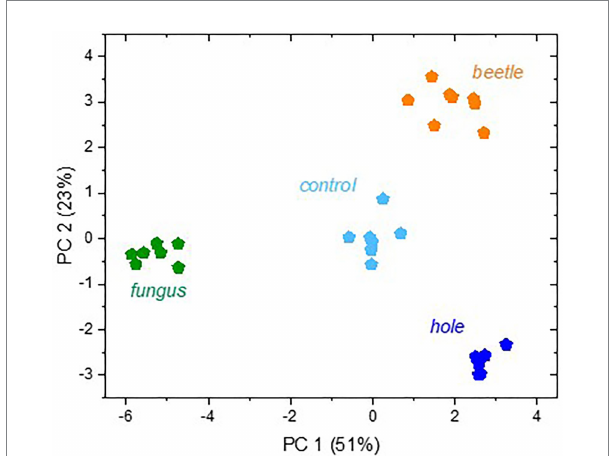
FIGURE 4 Score plot of a principal component analysis with all VOCs released from the beech bolts. Branch sections were either non-infested (“control”) or infested by X. germanus (“beetle”), or they were treated with an artificial hole without infection (“hole”) or with A. grosmanniae (“fungus”) infection. The abundances of all VOC from 7–8 replicates shown in Table 2 were log transformed and used for PCA.